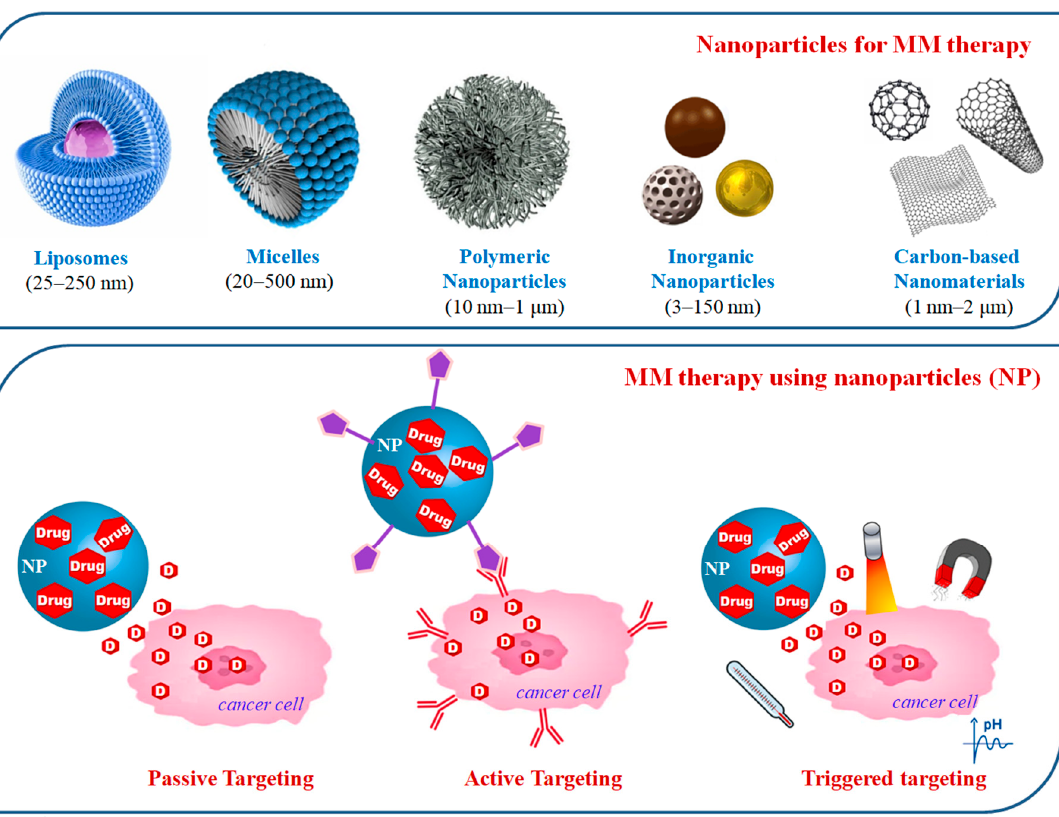
Figure 1. Nanodelivery approaches for multiple myeloma (MM) treatment.